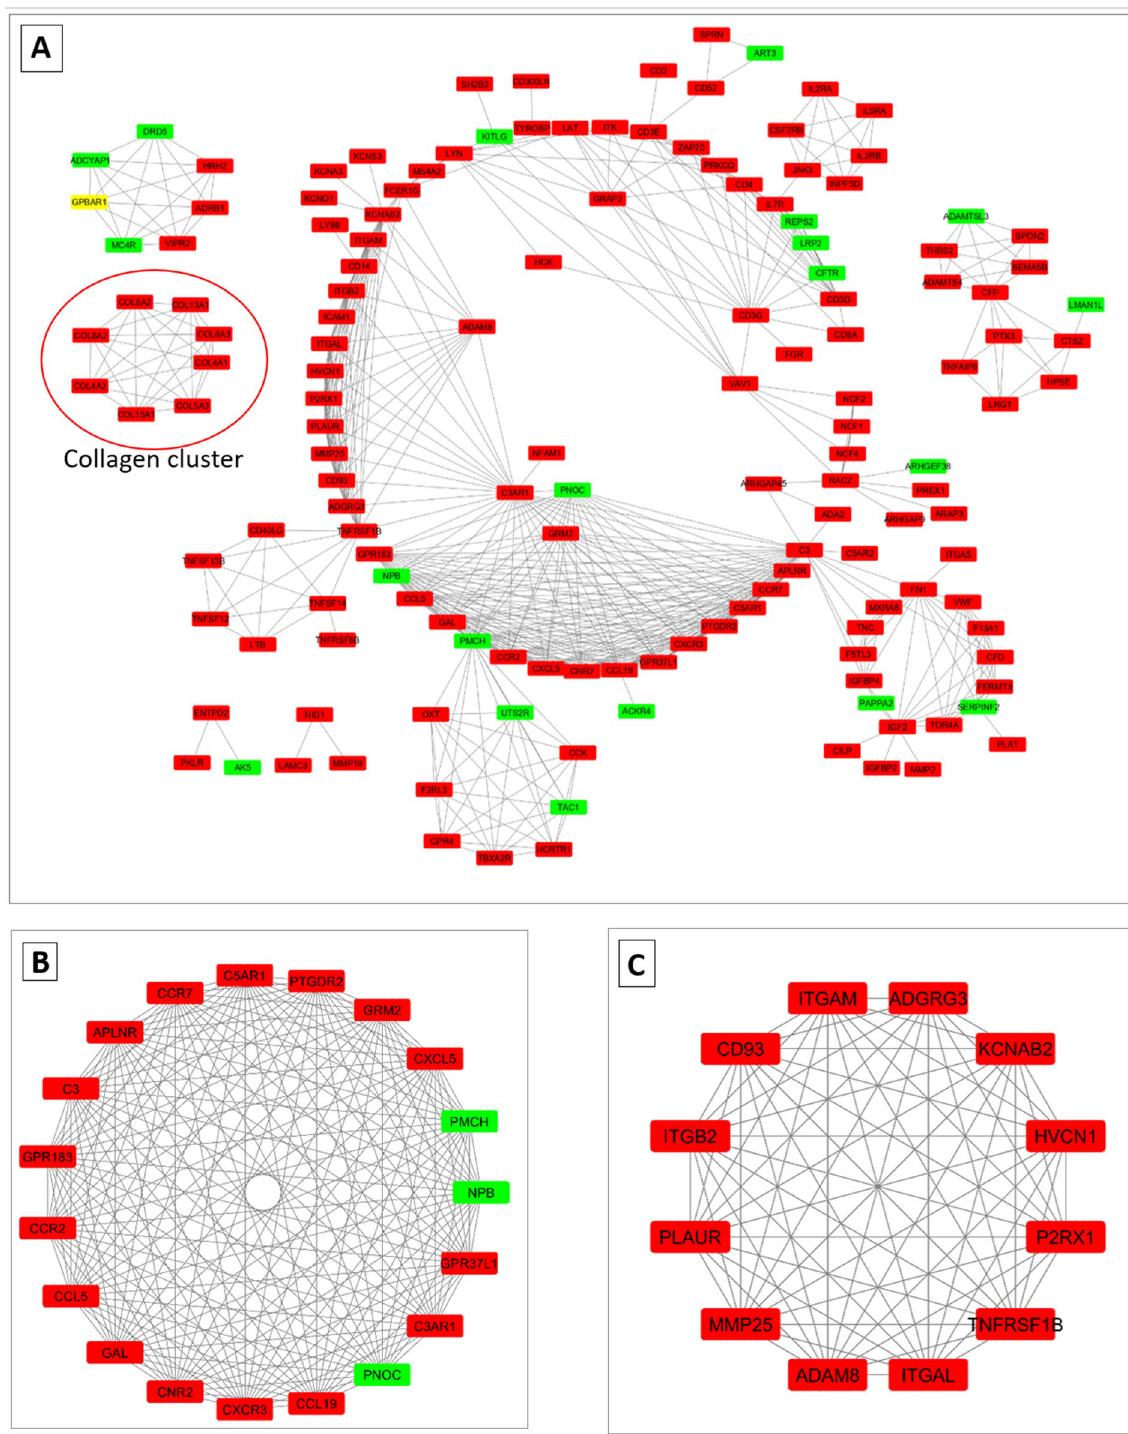
Figure 2. Protein–protein interaction (PPI) network and hub clustering modules. Red color represents genes up-regulated in anagen and green color represent genes downregulated in the anagen ( A ) The PPI network of overlapping differentially expressed genes between telogen and anagen. ( B ) Cluster 1 (MCODE score = 19). ( C ) Cluster 2 (MCODE score =